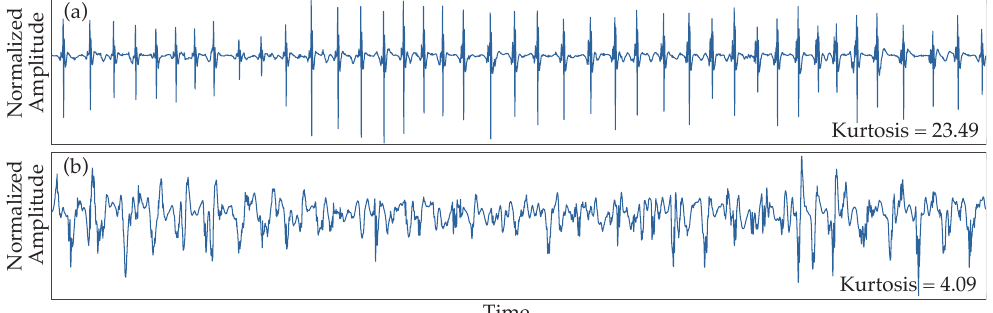
Figure 4. Kurtosis results to different fractionation degrees. ( a ) Type I AF EGMs normally present values of kurtosis higher than 20. ( b ) CFAEs are characterized by a low value of kurtosis. Type II AF EGMs show a wide range of intermediate values depending on each particular morphology.